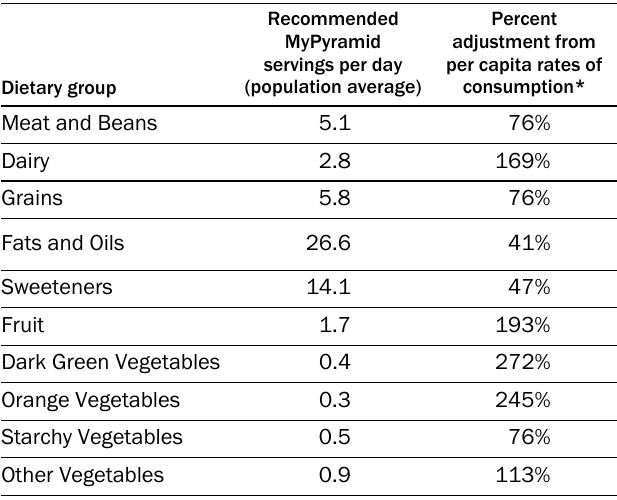
Table 1. Targeted Demand Rates Per